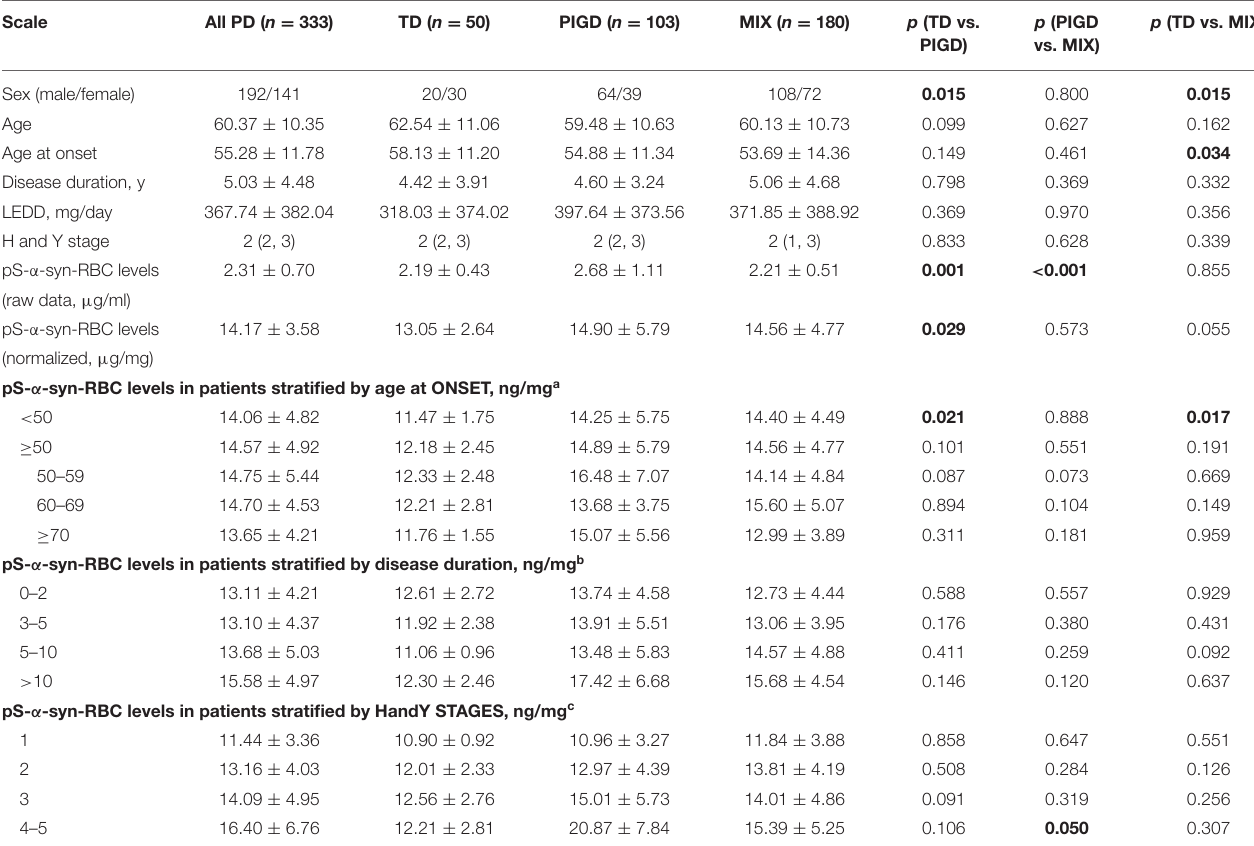
TABLE 2 | Overall and clinical variable-stratified comparisons of pS-a-syn-RBC levels between motor subtypes of Parkinson’s disease. Scale All PD ( n = 333) TD ( n = 50) PIGD ( n = 103) MIX ( n = 180) p (TD vs.